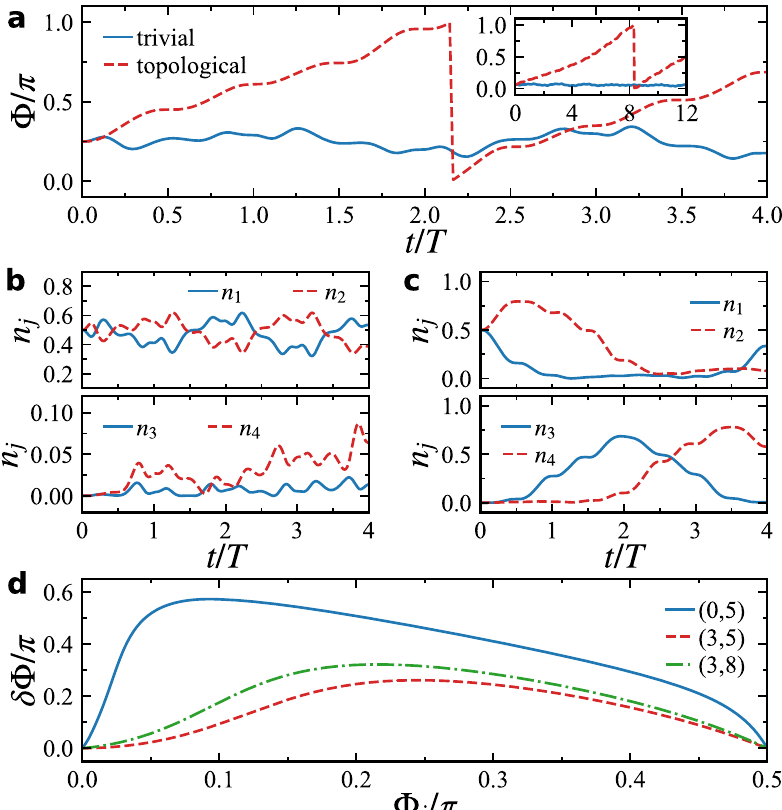
Fig. 3 Numerical results of the MO rotation. a Evolution of the polarized angle Φ for the trivial (blue-solid lines) and topological pump (red- dashed lines). We set the initial polarized angle Φ i = π /4 at t i = 0. Other parameters are the same with Fig. 2. The inner panel of ( a ) shows the case of N s = 16. b , c The evolution of the atomic densities in the ( b ) trivial and ( c ) topological pump. n j stands for the density occupied in j j i . d The topological MO rotation δ Φ = Φ f − Φ i as a function of the initial polarized angle Φ i for various parameter sets ( Δ 0 , α 0 ). The evolution processes four periods of pump cycling (i.e., t f − t i = 4 T